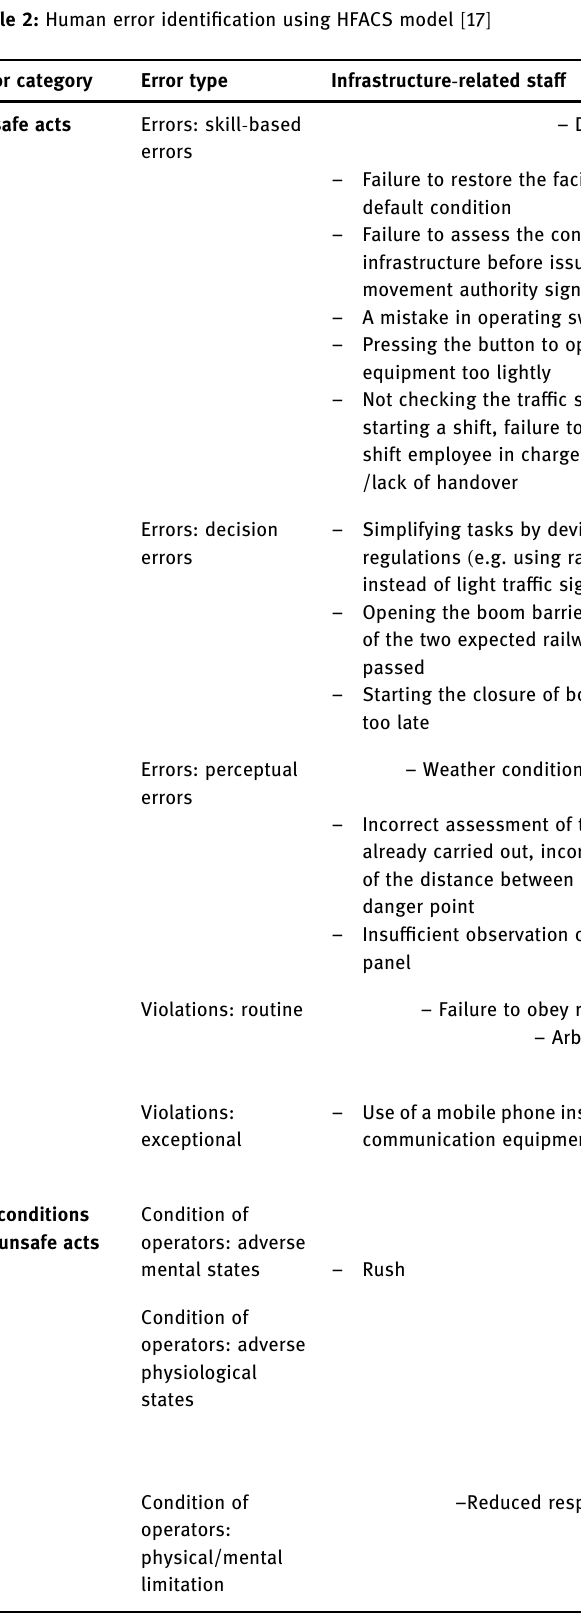
Table 2: Human error identi fi cation using HFACS model [ 17 ]